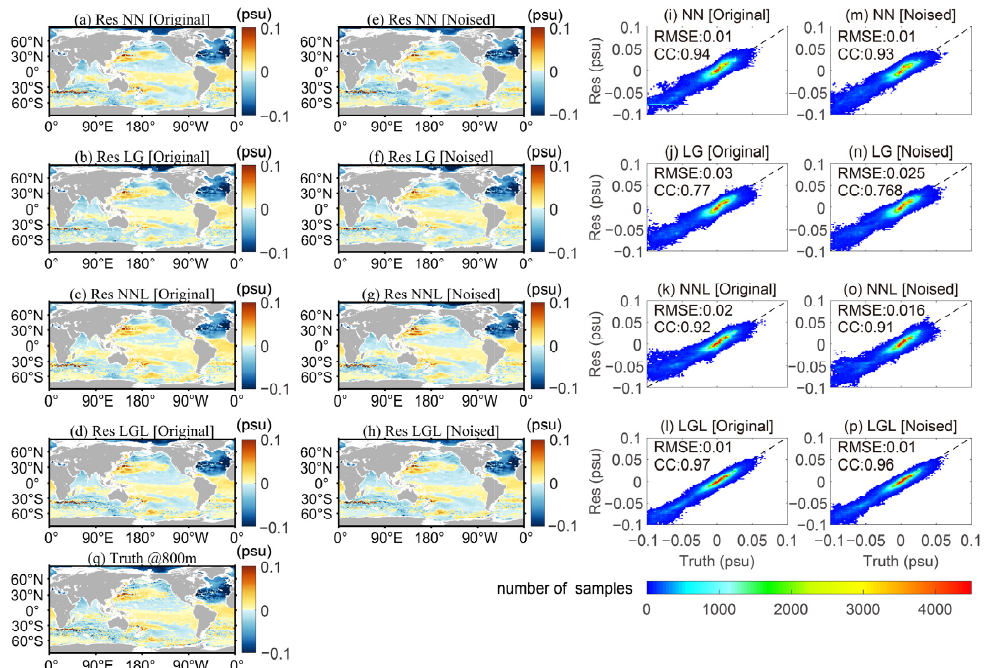
Figure 5. Spatial distribution of reconstructed data and density scatter plots of reconstructed vs. truth values for the four experiments at 800 m depth in January 2016. ( a – d ) and ( i – l ) Reconstruction based on the original synthetic dataset. ( e – h ) and ( m – p ) Reconstruction based on the noised synthetic dataset. ( q ) Truth value of CNRM-CM6-1-HR. The color-coded dots represent the number of samples.